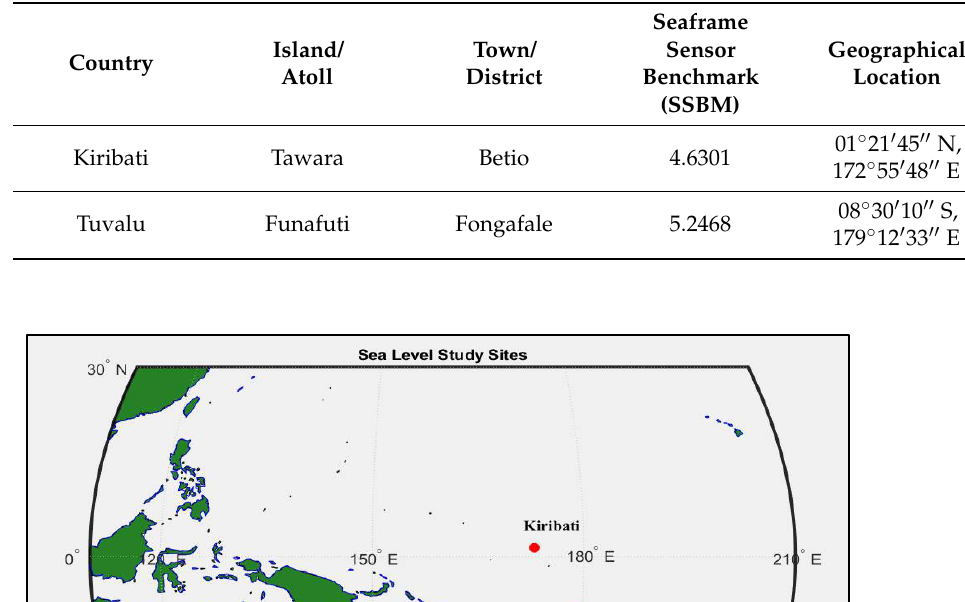
Table 1. Specific geographical location and description of the two data sites.